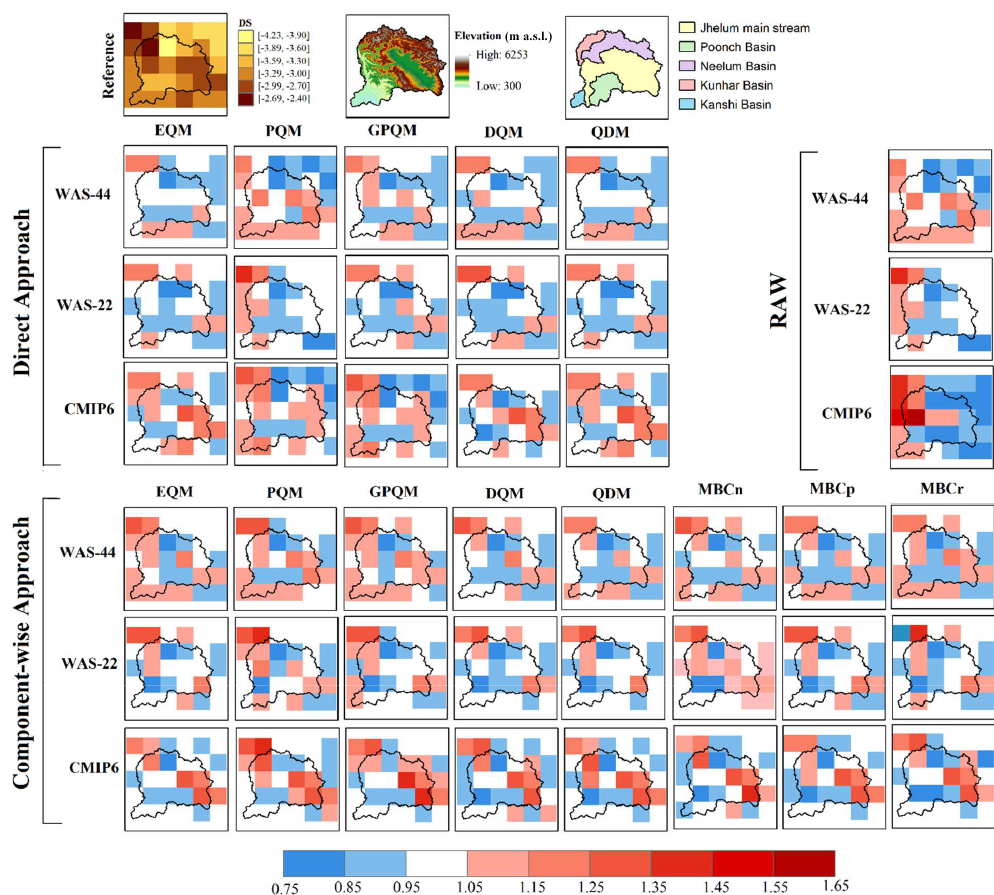
Figure 3. Median dry severity (DS) in the reference dataset expressed in accumulated SPEI units (first row, left), digital elevation model in meters above sea level (first row, center) and location of sub-basins (first row, right), and biases (as a ratio of model to reference) of DS for the multi-model raw and bias-corrected ensembles for the two bias correction approaches and all methods